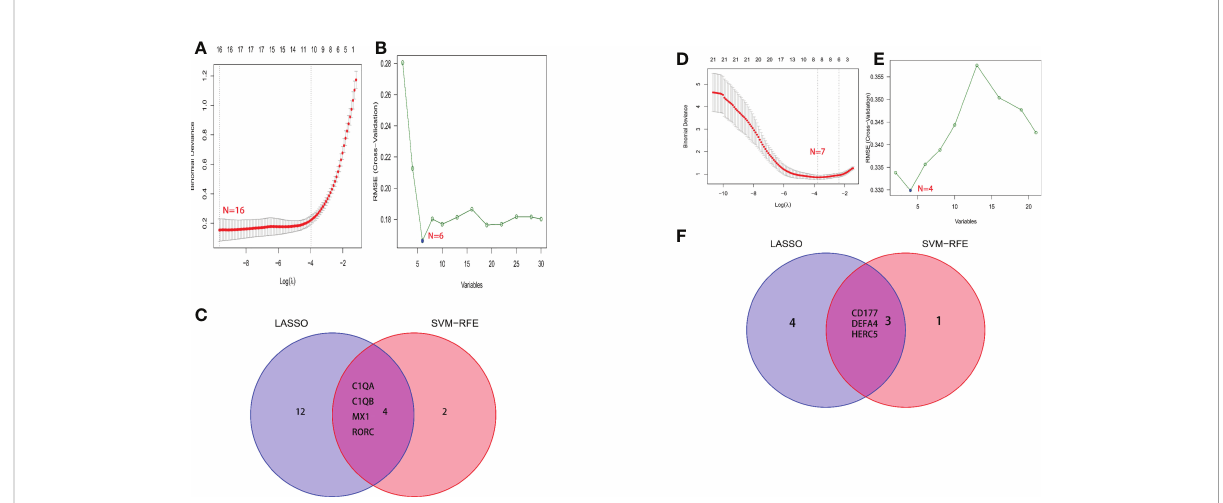
FIGURE 3 Screening process for diagnostic biomarkers of LN. (A, D) The LASSO model. (B, E) The SVM-RFE model. (C, F) LASSO and SVM-RFE overlap biomarkers. (A-C) Kidney tissue; (D-F) Peripheral